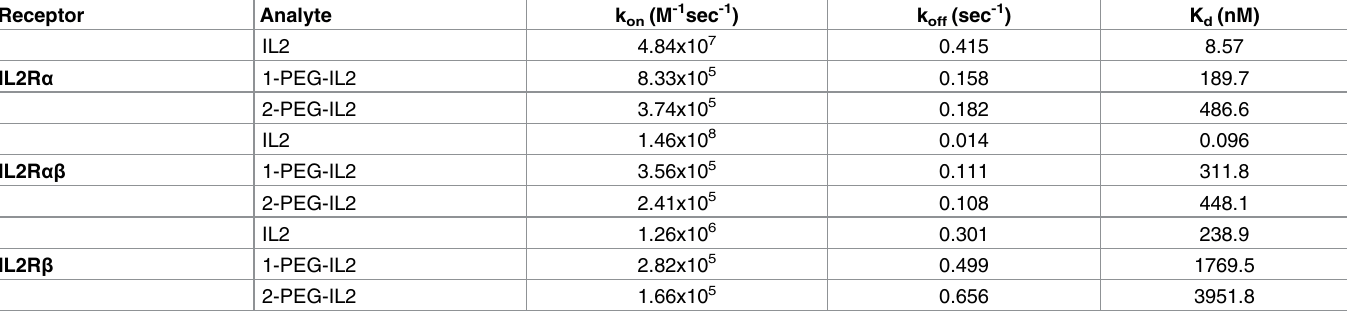
Table 1. The effect of PEGylation is greatestat the IL2R αβ complex bound to the SPR chip. Summary of binding kinetics for IL2 and active conjugated- IL2 species derivedfrom NKTR-214 at the human IL2R α ,IL2R β , or IL2R αβ .IL2R αβ simulatesthe heterotrimeric IL2R αβγ ,whereasIL2R β simulates the het- erodimericIL2R βγ